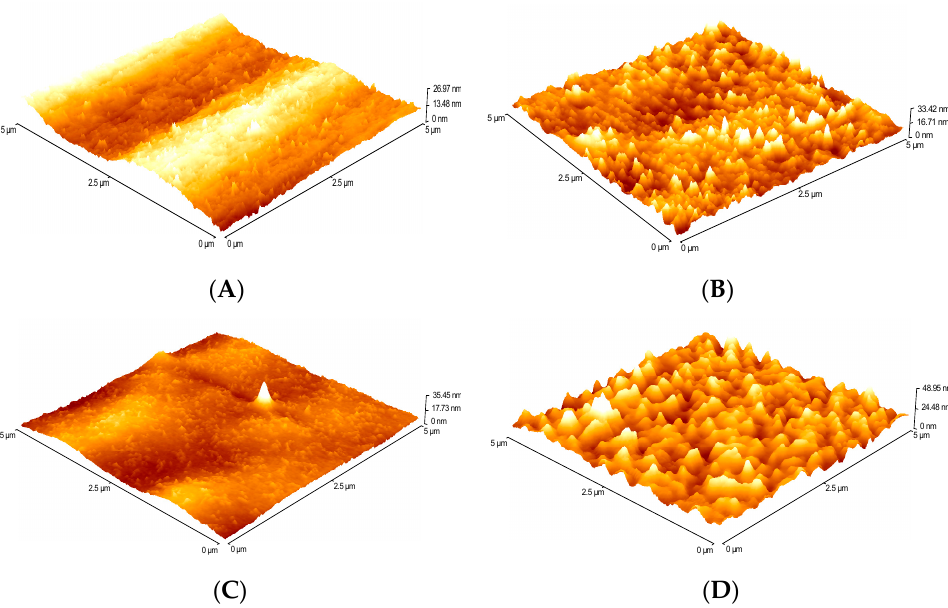
Figure 12. AFM images: ( A ) blend 6 nonplasma treatment, ( B ) blend 6 plasma treatment, ( C ) blend 13 nonplasma treatment, and ( D ) blend 13 plasma treatment .